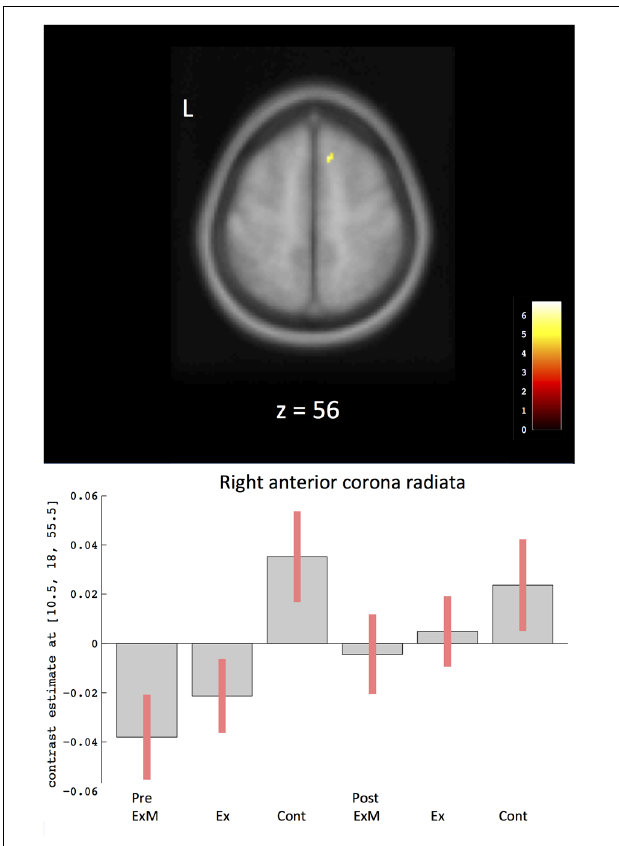
FIGURE 4 | Changes in white matter volume in different brain areas after intervention. The axis of ordinate displays changes based on β parameter estimates (with 90% confidence intervals) of the peak voxels within the respective clusters. As a ROI, we compared pre- and post-intervention contrasts between the three groups to eliminate the possibility of pre-intervention differences in WMV: (post_ExM > pre ExM) > (post_Cont > pre_Cont) and (post_Ex > pre_Ex)